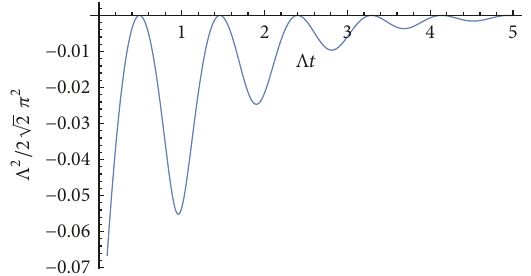
̇𝜙 ̇𝜙⟩ after regulation in (47).